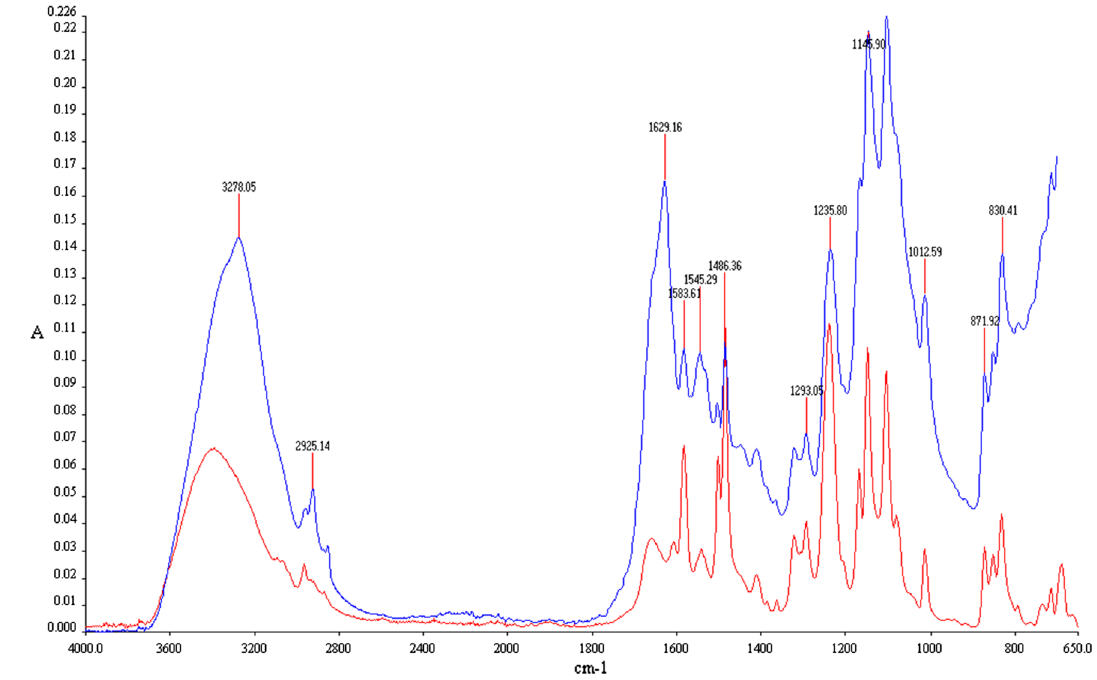
Fig. 9 FTIR spectra of the virgin (red) and fouled (blue) Koch membrane